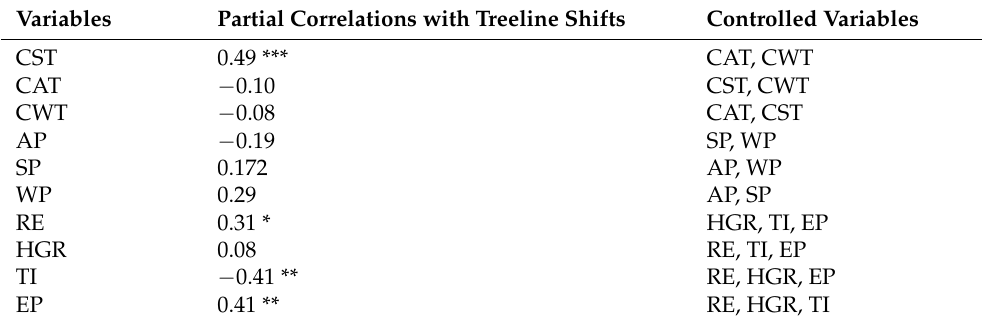
− 0.41 ** RE, HGR, EP 0.41 ** RE, HGR,